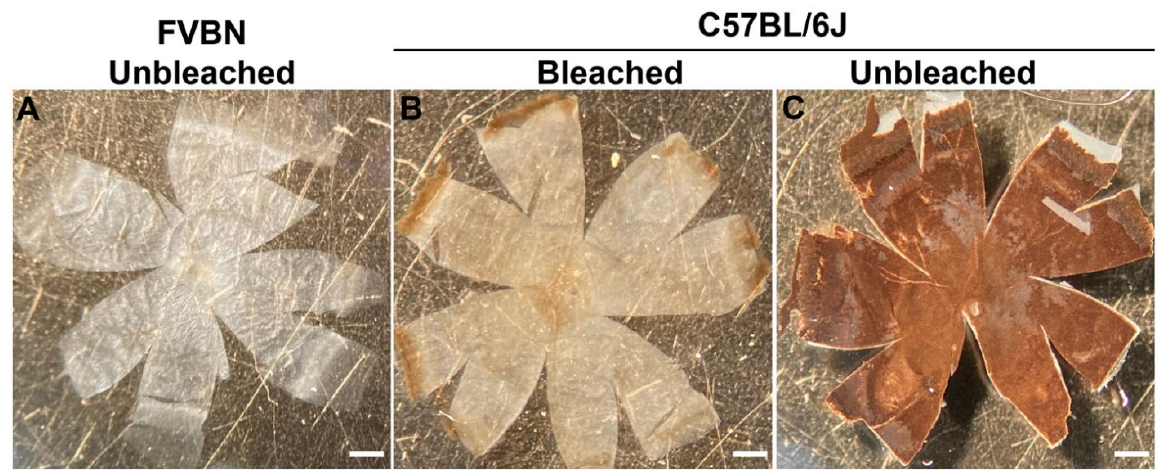
Figure 3. Whole choroidoscleral tissue from albino (FVBN, unbleached) ( A ), bleached C57BL/6J ( B ), and unbleached C57BL/6J ( C ) mice. Exposing the choroidoscleral tissue from pigmented C57BL/6J mice to 1% H 2 O 2 for 4–5 h at 55 °C in a water bath was sufficient to bleach almost all melanin in the tissue, as it becomes almost transparent. Representative images were from 6 ‐ week ‐ old FVBN and C57BL/6J mice and captured in digital format. Scale bars: 500 μ m.